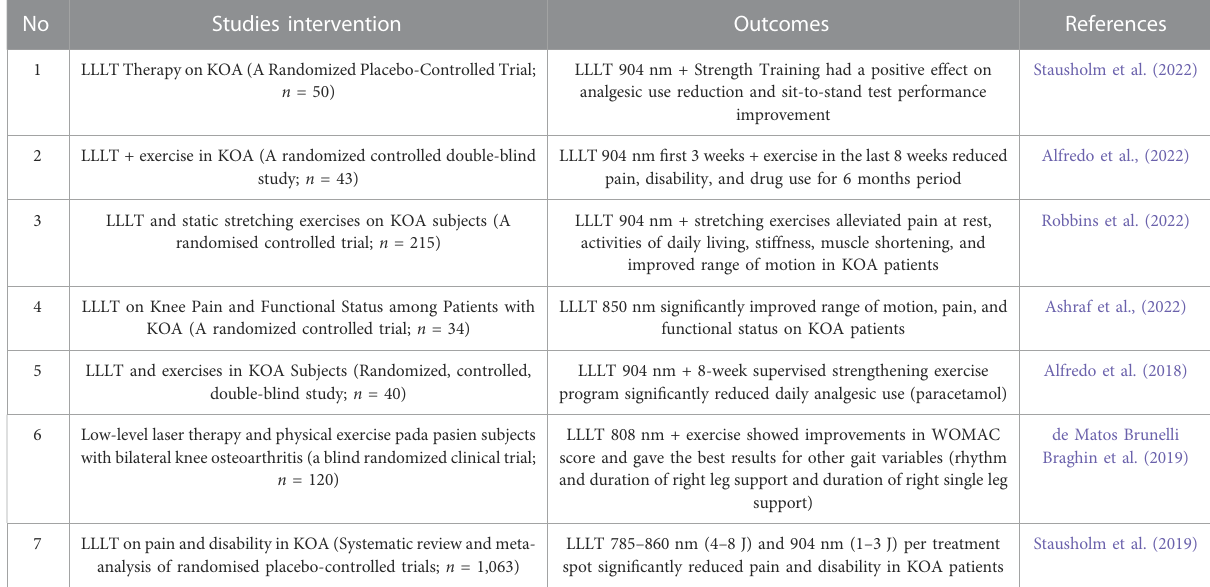
TABLE 1 Published clinical studies of low-level laser therapy on patients with knee joint osteoarthritis. No Studies intervention